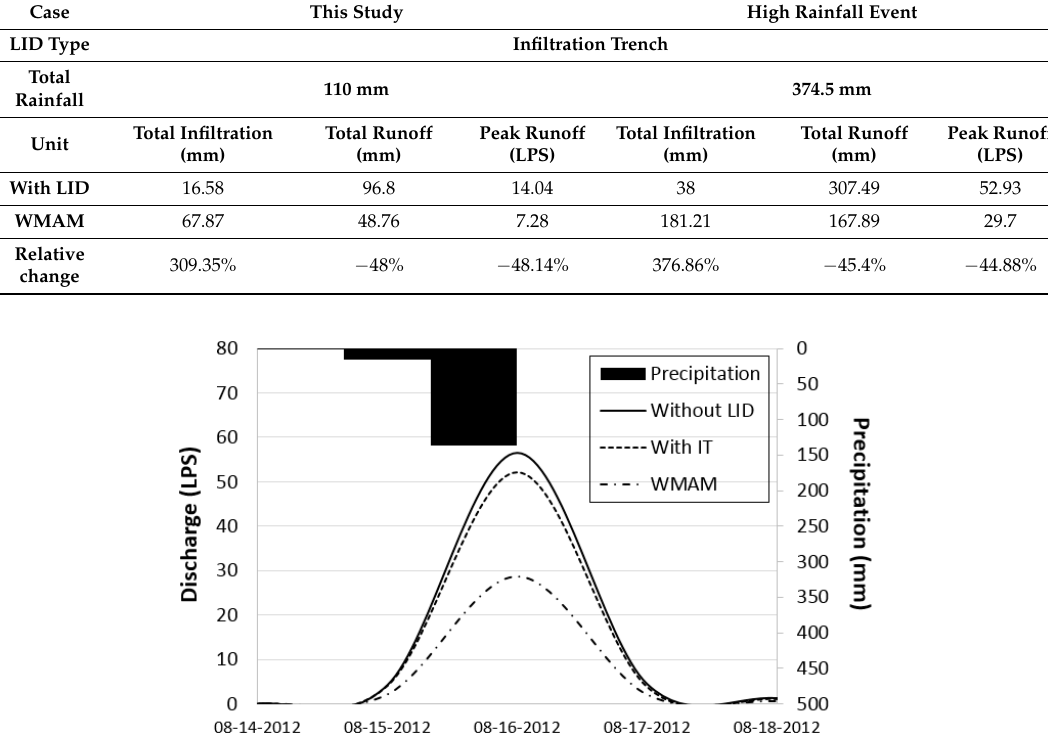
Table 8. Comparison of the WMAM results to a high-rainfall event.